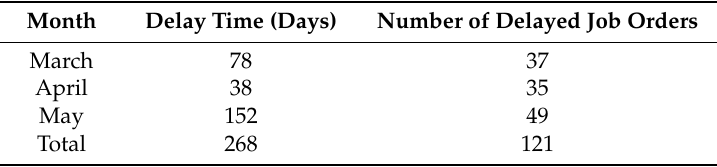
Table 8. The reassembly delay time (March 2016 to May 2016).